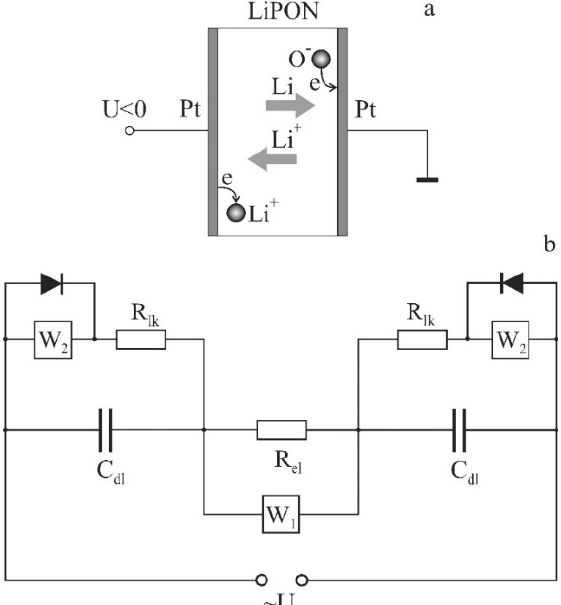
Figure 6. Structure of experimental cell Pt/LiPON/Pt: a —cell structure and direction of diffusion fluxes at constant voltage, and b —structural model of LiPON.